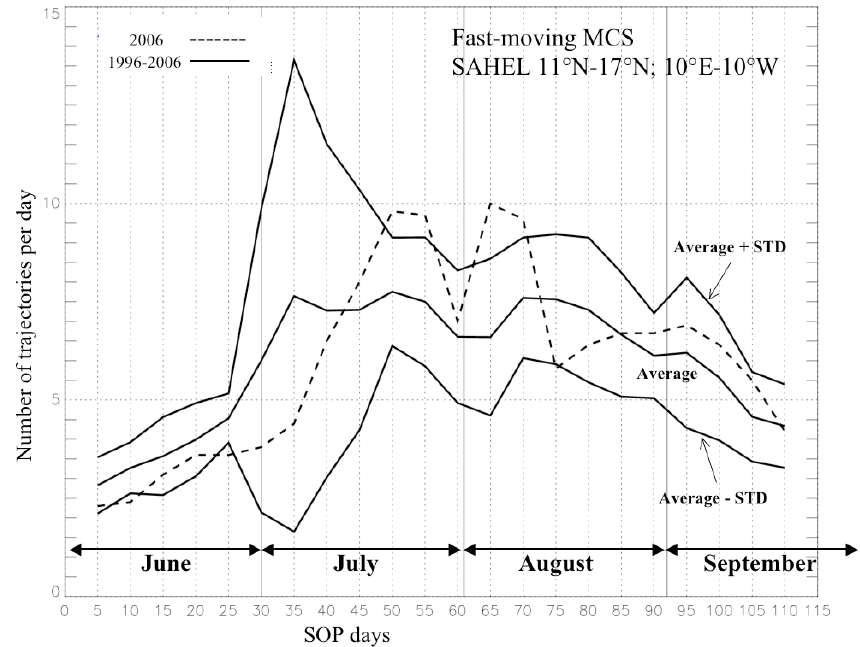
Figure 8. Five-day average of C3+C4 MCS tracks numbers per day detected over the Sahelian area 11°N-17°N/10°W-10°E including a 10-day running average (see details in the text). The black lines represent the evolution of the mean 1996–2006 track numbers as well as the evolution for the mean plus and minus one standard deviation, and the dashed line the 2006 evolution. The x-axis labels are expressed in days from June 1 st .